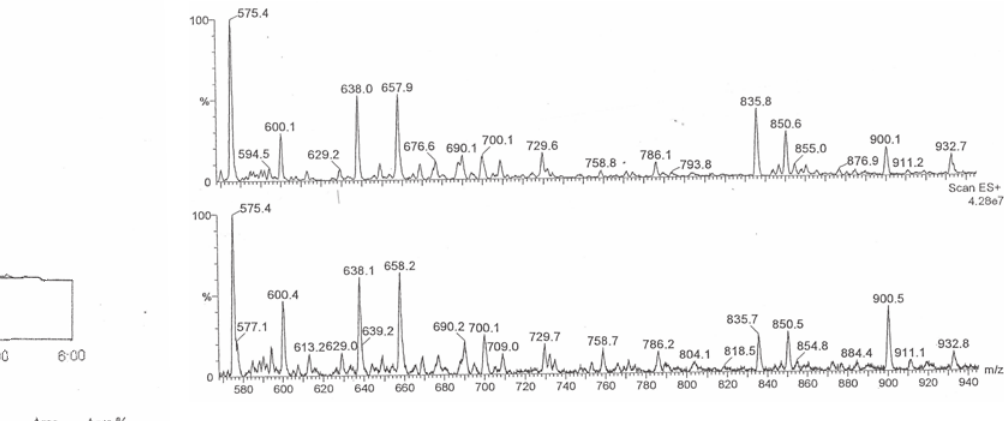
Figure 3. Electrospray ionization mass spectra of tryptic digests of the normal (top) and abnormal -chain (bottom). β